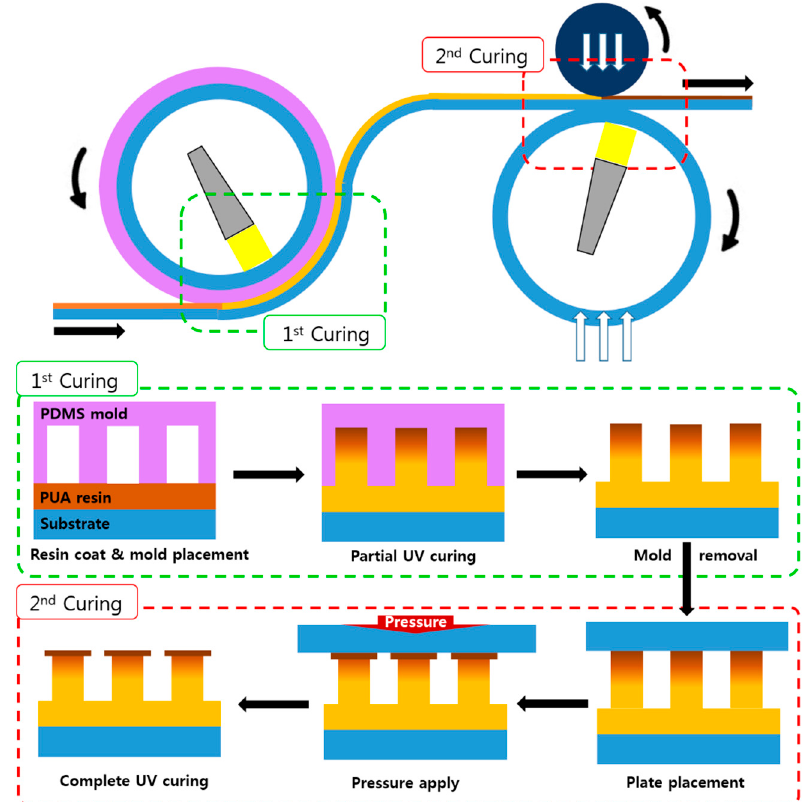
Figure 1. Schematic of the continuous fabrication process for mushroom-shaped dry adhesives and procedure for mushroom-shaped structures via two-step UV molding process.